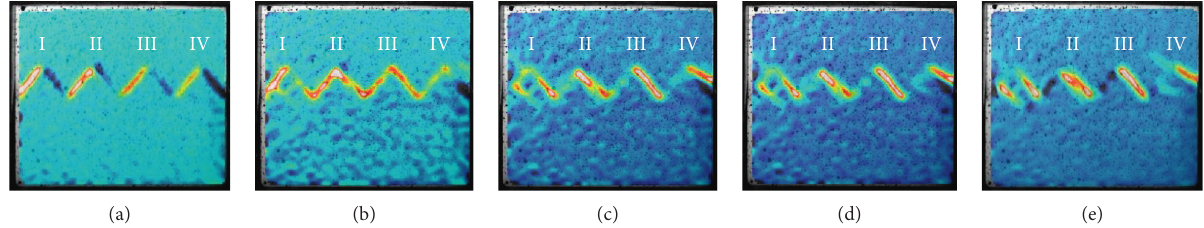
Figure 14: Typical development process of shear failure of jointed specimens (B-15).